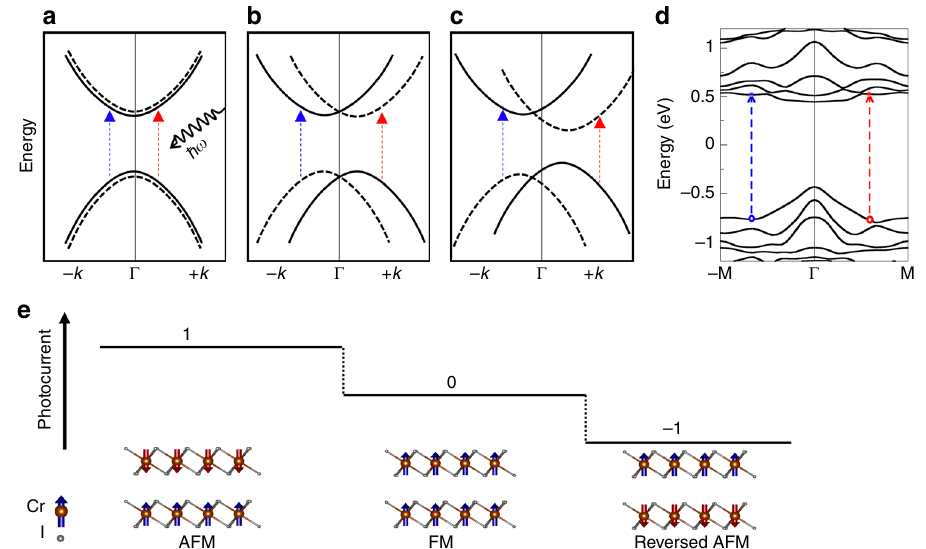
Fig. 1 Band structure symmetry-breaking and magnetic structures of the bilayer CrI 3 . Schematics of band structures a with both inversion symmetry ( P ) and the time-reversal symmetry ( T ), b with only T but P -breaking, and c with both P - and T -breaking. For both a , b , the light excitation ( ħ ω ) at + k and − k is symmetric to each other. However, such a symmetry is broken in c . As a consequence, excited electrons at + k and − k do not cancel each other in velocity, giving rise to a dc photocurrent. d The band structure of antiferromagnetic(AFM) bilayer CrI 3 . Here both P - and T are broken as the case of ( c ), violating the k to − k symmetry. The spin-orbit coupling is included. The Fermi energy is shifted to zero. e The AFM, ferromagnetic (FM) and reversed AFM phases display three distinct responses to a linearly polarized light – positive current state(1), zero current state (0) and negative current state( −